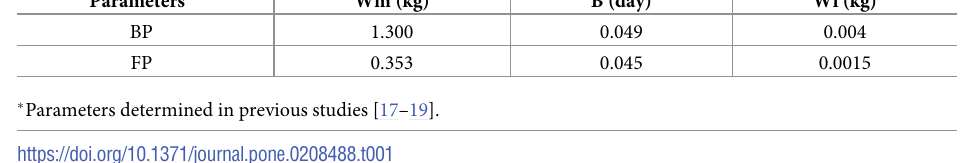
Table 1. Mature weight (Wm), deposition ratio (B), and initial weight (Wi) determined for body protein (BP) and feather protein (FP) in broiler chickens. Parameters � Wm